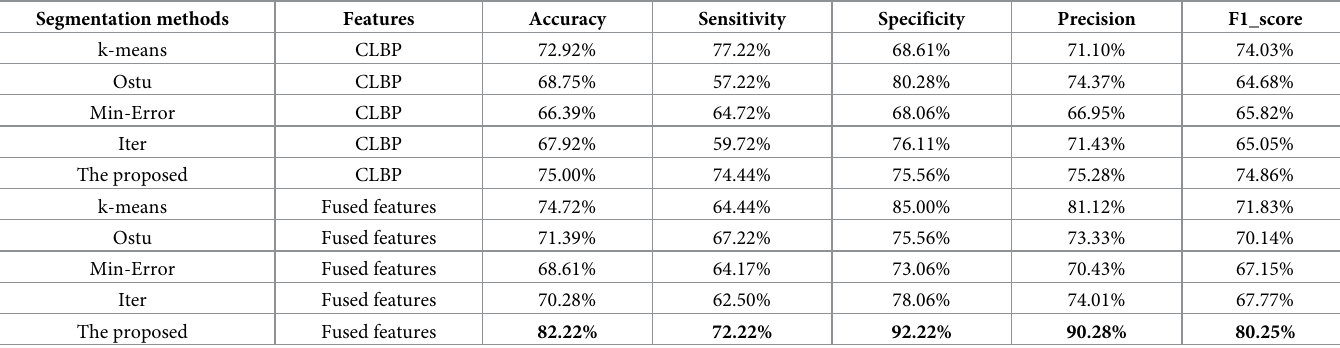
Table 8. Comparison of different segmentation methods at